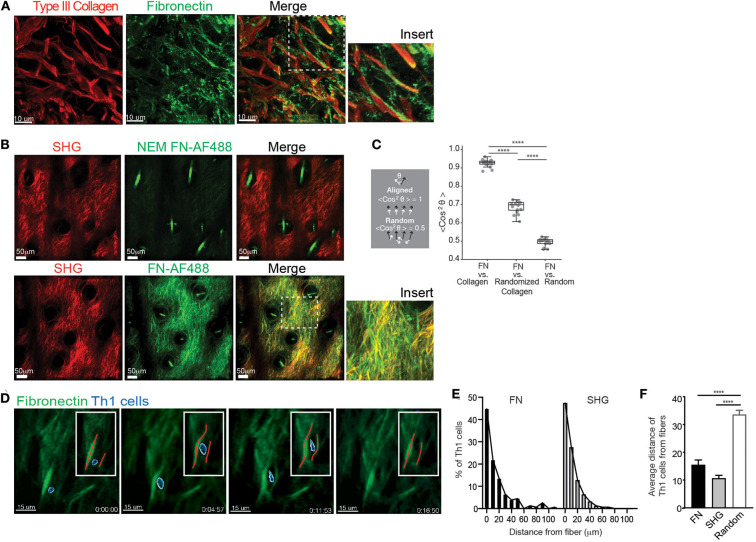
FN fibrils and Th1 migration. WT mice were intradermally immunized with OVA/CFA in the ear pinna and assessed by IHC of frozen sections (A) or IV-MPM (B) 3 days post-immunization. (A) The ear tissue was excised and frozen for IHC. Eight micrometer slices were imaged using confocal microscopy. Type III collagen (red) and FN (green), scale bar 10 μm. (B) 100 μg of control NEM-treated FN-AF488 (NEM FN-AF488) (top) or FN-AF488 (bottom) were given i.v. to immunized mice 4 h prior to IV-MPM. Second harmonic generation (SHG) (red), AF-488 FN (green), scale bar 50 μm. (C) Measurement of the alignment of the ECM images in (B) measured as the average cosine squared of the angle between the local fibronectin orientation and either the local collagen orientation, a randomized distribution of the collagen orientations, or a random distribution. Two perfectly aligned distributions have a value of 1, while two completely random distributions have an average value of 0.5. Each dot represents one z-plane of the image stack, containing 200+ vectors. Statistics by Mann-Whitney test. ****p < 0.0001. (D) OVA-specific Th1 cells labeled with CMTMR were adoptively transferred to WT mice and recipient mice immunized with OVA/CFA. Day 3 post-immunization, mice received 100 μg FN-AF488 4 h prior to IV-MPM. Th1 cells (blue, pseudo-colored), FN-AF488 (green), scale bar 10 μm. Inset, red lines placed along the midline of the FN fiber. Time lapse sequence of images from Video 1. (E,F) Quantitation of Th1 distance to nearest fiber, either FN or SHG. (E) Frequency distribution of Th1 cells from FN and SHG fibers. (F) Th1 cell distance from FN or SHG fibers compared to random distribution in same imaging field (Random). Number of cells imaged, >150. Statistics by ANOVA. ****p < 0.0001. Two to three independent experiments.